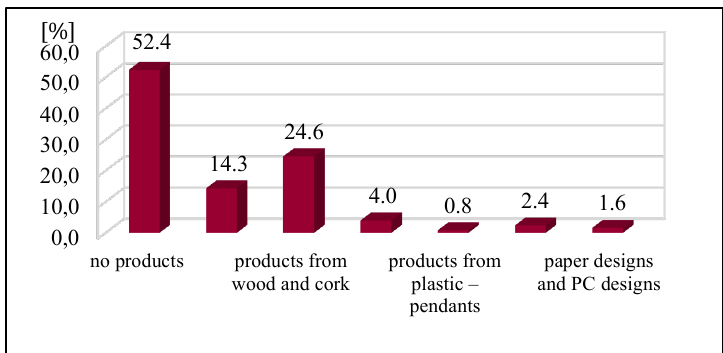
Fig. 5. Results in answers to the item no. 4: „ Mention tools, instruments and machines you used at the lessons of Technical education“.